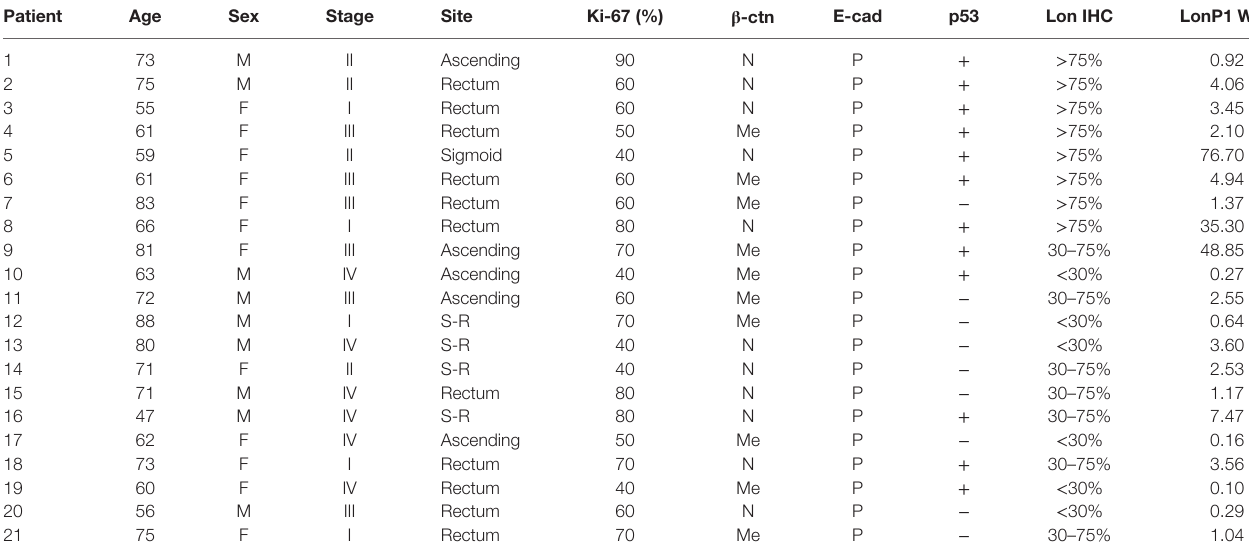
TaBle 2 | Demographic characteristics, tumor stage, Ki-67, β -catenin ( β -ctn), E-cadherin (E-cad), p53, LonP1 expression in 21 colorectal cancer samples.